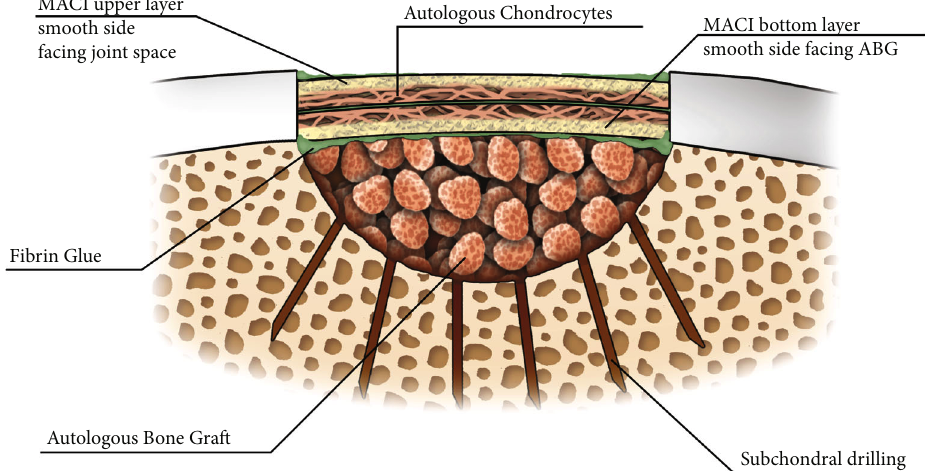
Figure 1: Bone graft is placed up to the subchondral plate level. Base drilled with 1.5mm drill bit.